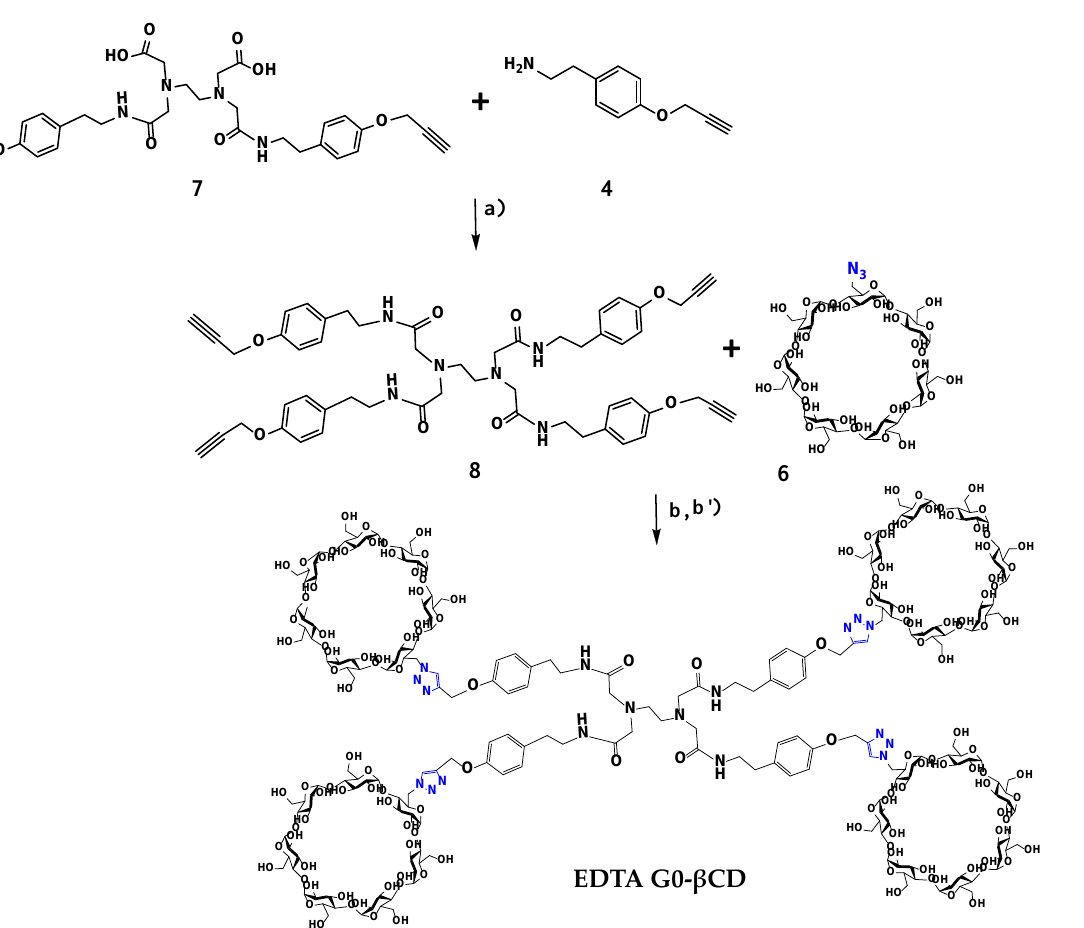
Scheme 2. Synthesis of EDTA G0- βCD dendrimer. Conditions: (a) EDC·HCl, HOBt, 2.2 eq